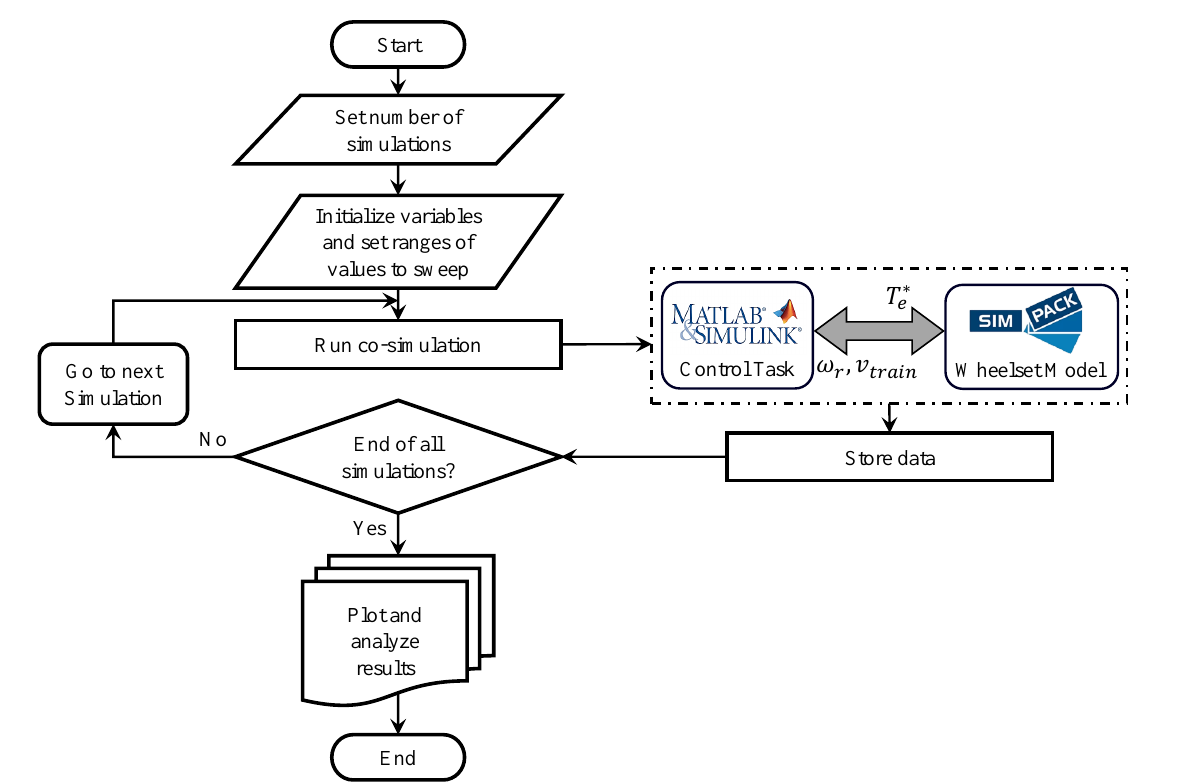
Figure 10. Flow chart for parametric sweep analyzes of torsional vibrations in mechanical drives using MATLAB-SIMPACK co-simulation tool.